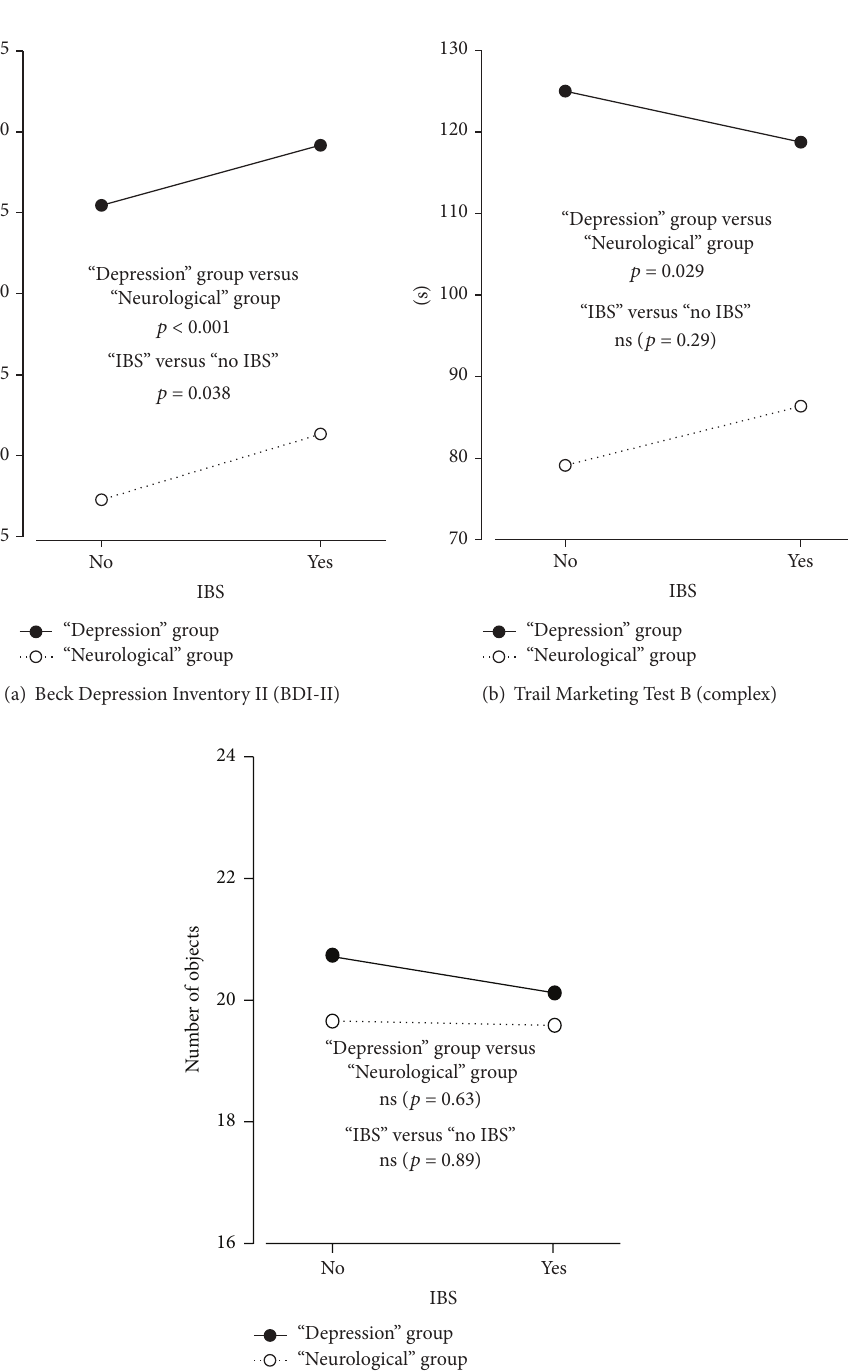
Figure 1: Estimated marginal mean scores for Beck Depression Inventory II (a), Trail Making Test B (b), and Brief Visual Memory Test immediate total recall (c) in the “Depression” and “Neurological” groups divided into patients with and without IBS after adjusting for age, sex, and